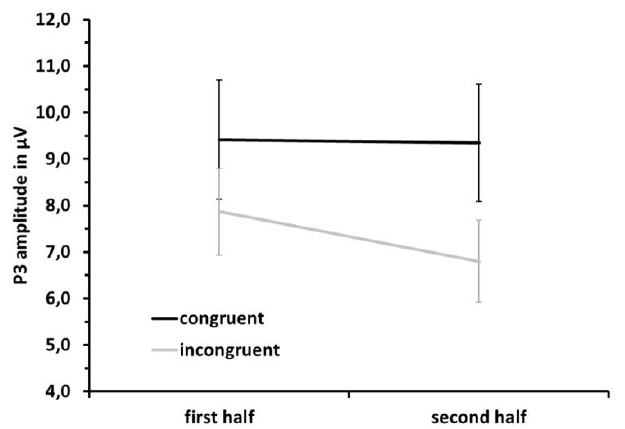
Figure 8. Mean P3 peak amplitude for congruent (black) and incongruent (grey) trials in the first and second half of the dataset to visualize the congruence × half interaction. Error bars depict standard error values.